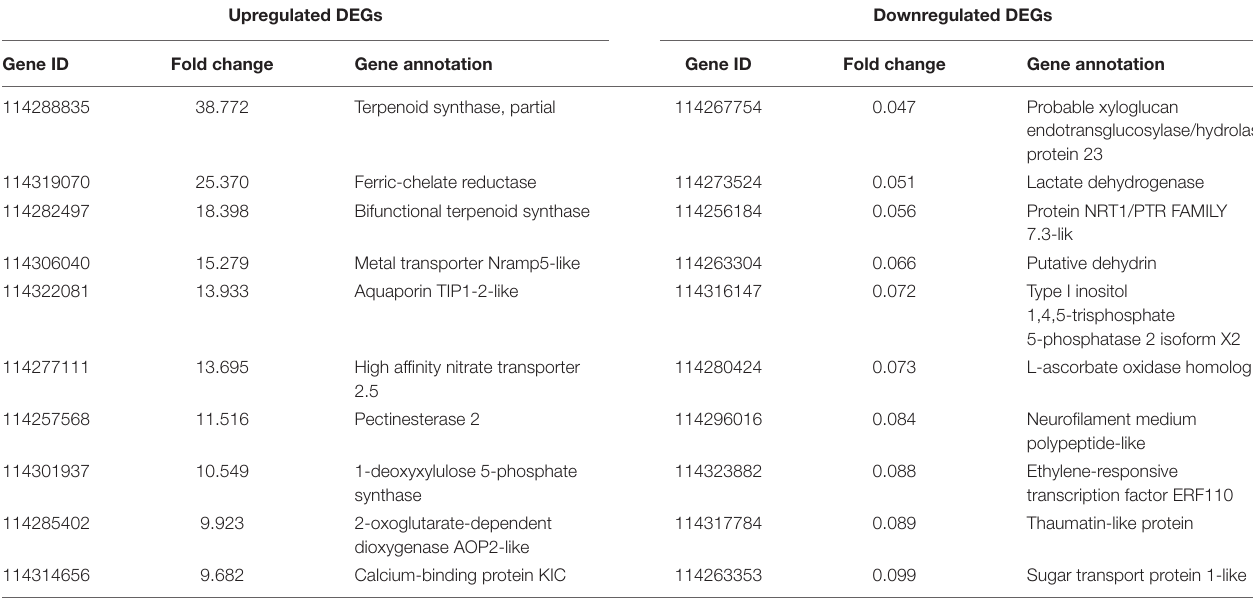
TABLE 6 | The most 10 upregulated and downregulated DEGs between the mycorrhizal and non-mycorrhizal